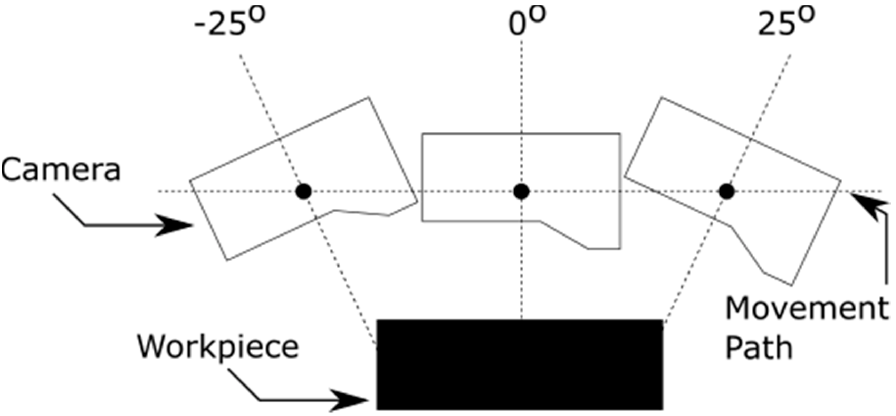
Figure 1. Camera setup and different angle extremes.